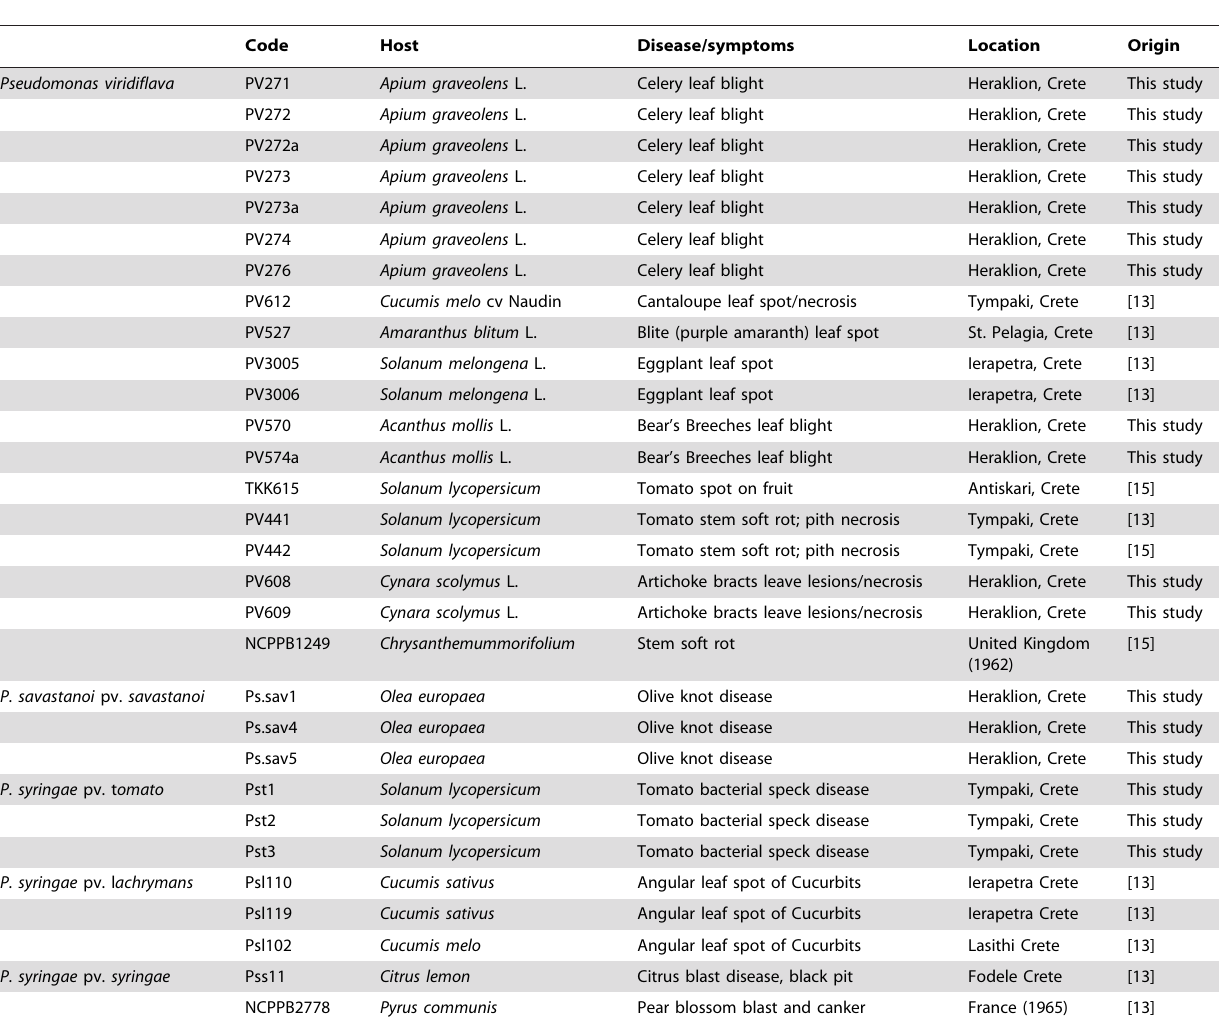
Table 1. Bacterial strains used in this study for biochemical characterization and pathogenicity